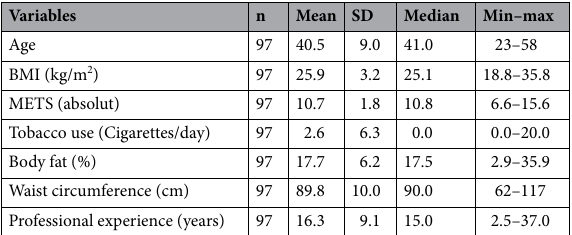
percentages, and increasing years of work experience are inversely related with inversely to lower cardiorespira- tory fitness levels. The unadjusted analysis describes significant associations for higher cardiorespiratory fitness with lower BMI (p ≤ 0.0001), lower waist circumference (p ≤ 0.0001), body fat percentage (p ≤ 0.0001), RSBP (p = 0.0061), lower triglycerides (p = 0.0018) and total cholesterol levels (p = 0.0443). After adjusting for age, there are significant differences between higher cardiorespiratory fitness and lower BMI (p ≤ 0.0001) and abdominal